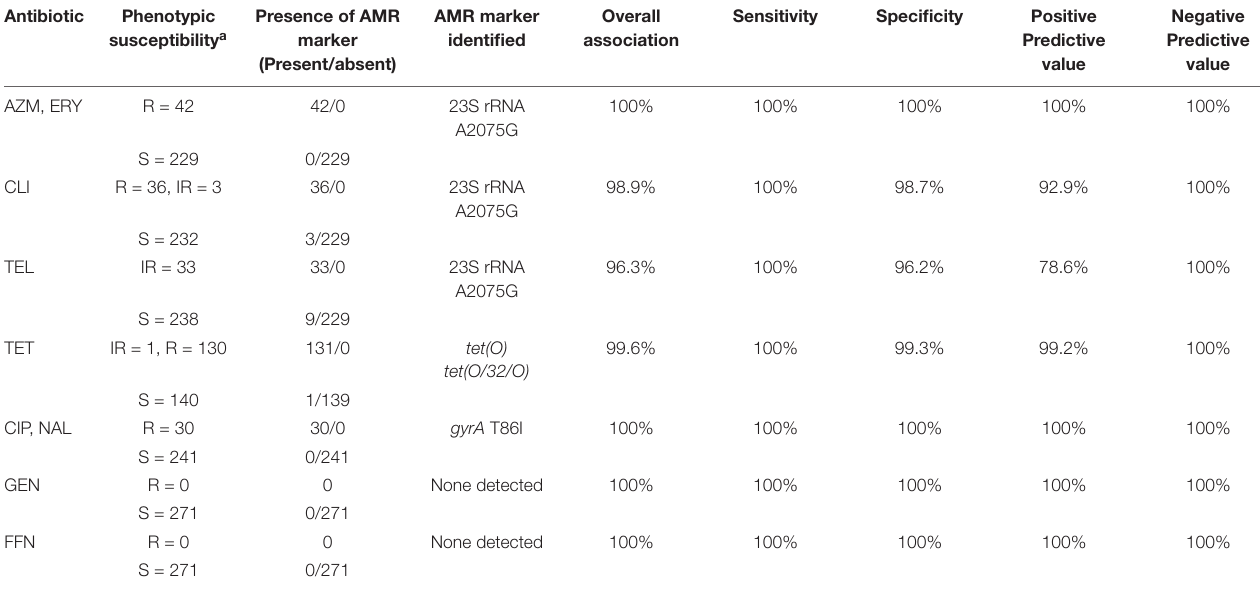
TABLE 2 | Concordance of C. jejuni and C. coli resistance phenotypes to resistance genotypes predicted using GeneSeekr and manual alignment.